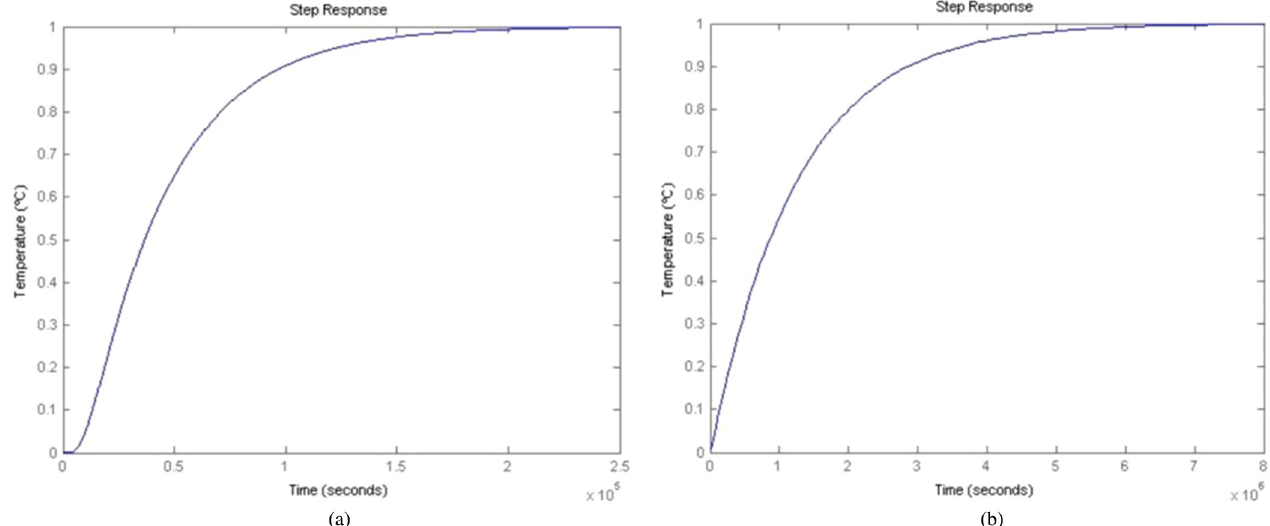
Fig. 7. System response when it is subjected to a unitary step disturbance (Extracted from Matlab). (a) Inside insulation and outside thermal mass. (b) Outside insulation and inside thermal